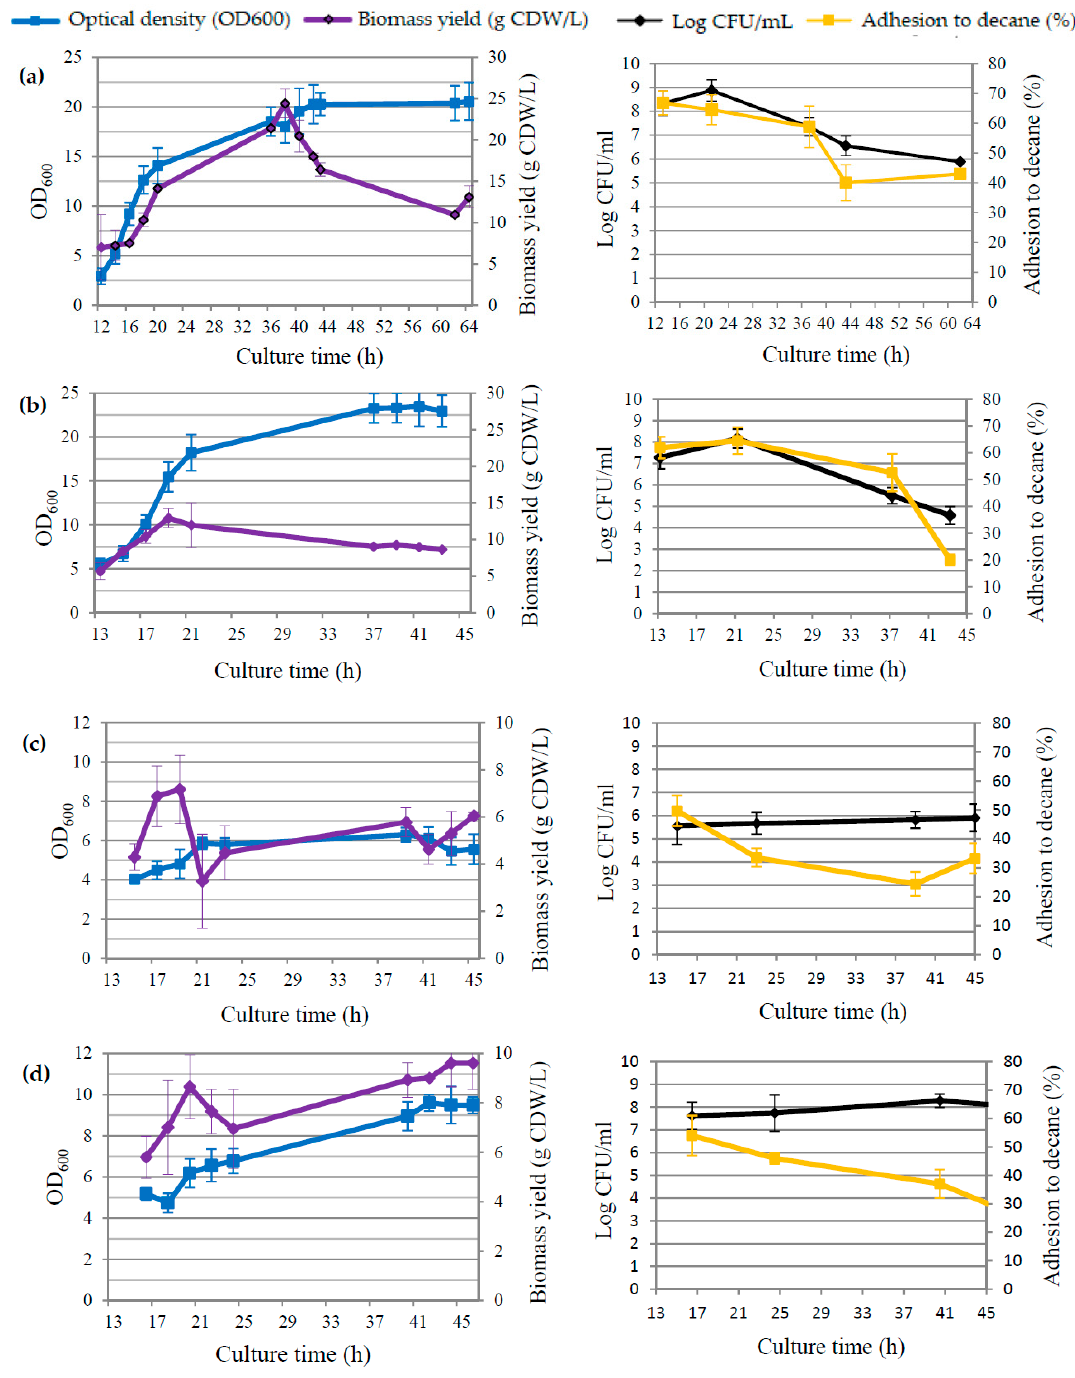
Figure 2. Growth curves illustrating of either OD 600 readings (blue line) and biomass yield (violet line) or viable cell counts (CFU/mL) (black line) and percentage of adhesion to decane (yellow line) for culture 1 ( a ), culture 2 ( b ), culture 3 ( c ), and culture 4 ( d ).